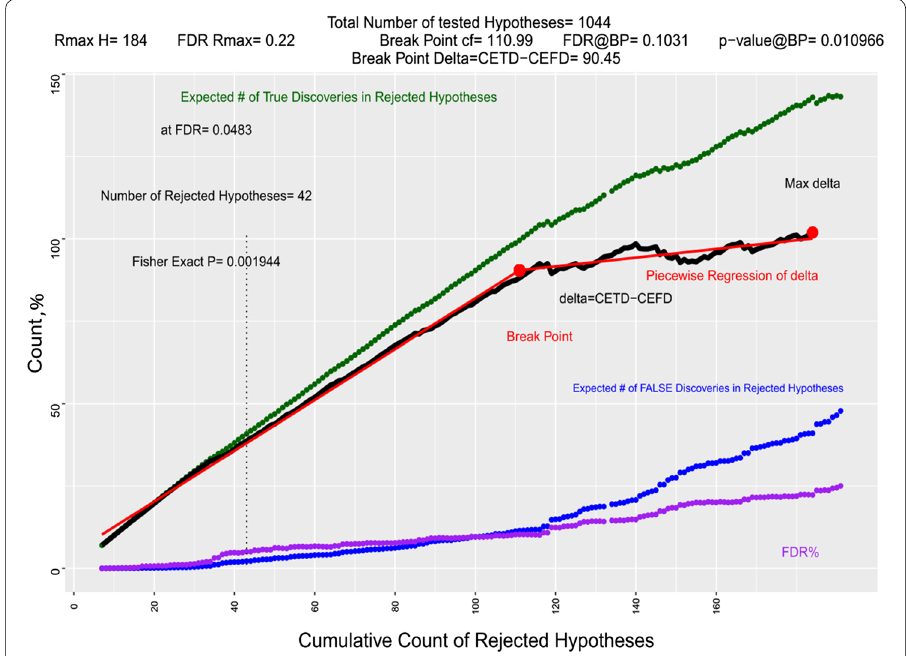
Fig. 3 Maximum δ and the breakpoint of piecewise